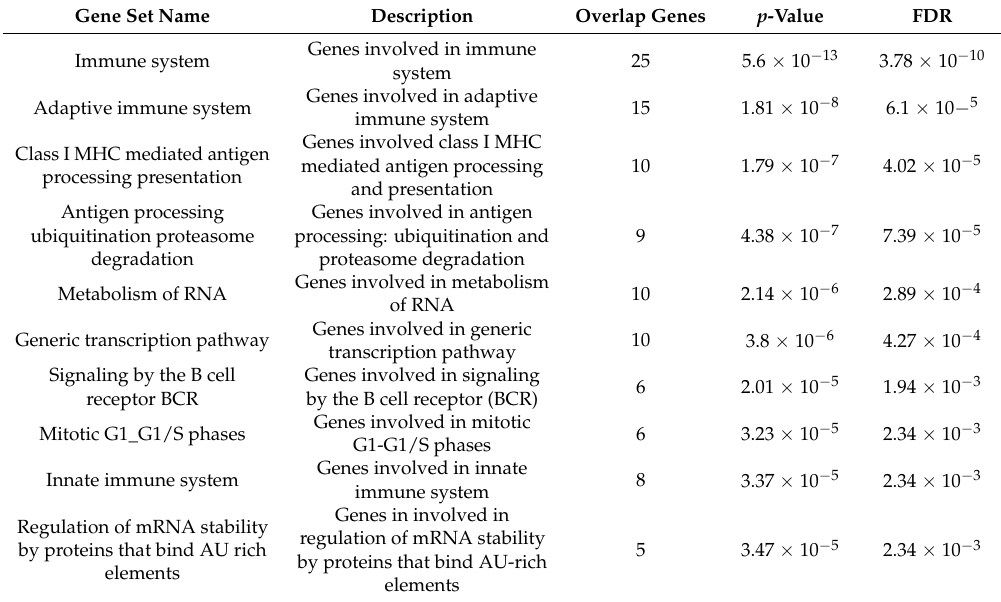
Table 2. Top 10 enriched Reactome pathways using the top 200 genes ranked by reGAIN interaction pairs from the Baylor gene expression discovery data. The first column indicates the name of each pathway. The second column provides a description of the biological activity of the pathway. The third column provides the number of genes overlapping between the pathway and query list. The fourth and fifth columns show the p-value using a hypergeometric test and False Discovery Rate (FDR) of the enrichment,